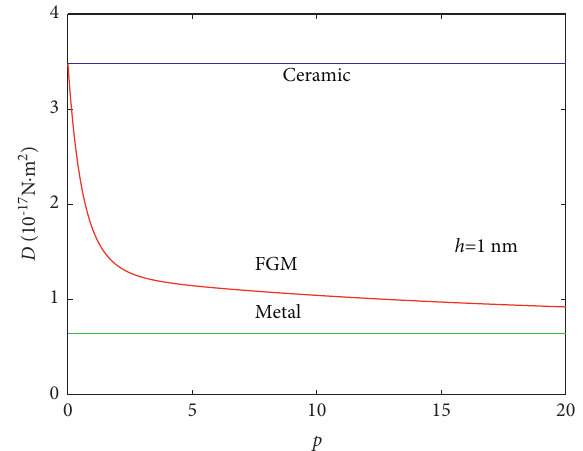
Figure 3: Effects of the gradient index on the equivalent bending